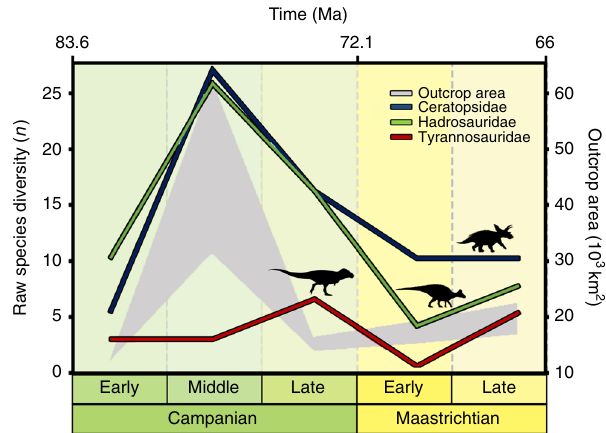
Fig. 1 Raw diversity trends for the three clades of dinosaurs in this study plotted against outcrop exposure area. The plot shows the apparent correlation of this sampling proxy with diversity curves for these clades of dinosaurs (Ceratopsidae, Hadrosauridae, and Tyrannosauridae). Tyrannosauridae silhouette by Jack Mayer Wood (CC BY 3.0 license: https://creativecommons.org/licenses/by/3.0/ CC BY 3.0); Hadrosauridae silhouette by Pete Buchholz (under CC BY-SA 3.0 license: https://creativecommons.org/licenses/by-sa/3.0/); and Ceratopsidae silhouette by Mariana Ruiz (modi fi ed by T. Michael Keesey) under the Public Domain Mark